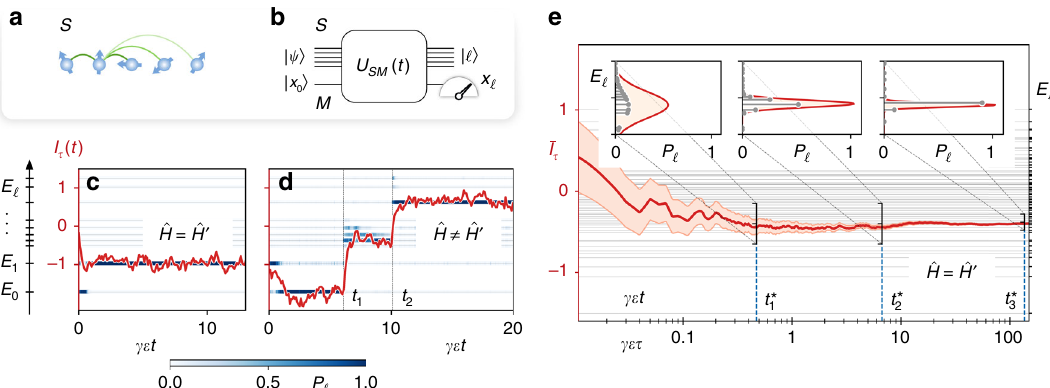
Fig. 1 QND measurement of a many-body Hamiltonian ^ H in a quantum simulator setting. The many-body spin system S , shown in a , is entangled with an R ^ H ^ H ^ P t t Þ ¼ exp f(cid:2) i ancillary system M (meter) by the unitary ^ U (cid:3) I þ ϑ ð t 0 Þ (cid:3) (cid:4)g . b Subsequent reading of a meter value x ‘ (cid:5) x 0 þ E ‘ d t 0 ½ SM ð 0 prepares the many-body system in an energy eigenstate ‘ j i with the eigenvalue E ℓ . c Single trajectory simulation (4) and (5) of an ideal QND measurement for the Ising Hamiltonian (3) for N = 5 spins, α = 1.5, h ∕ J = 1.5. The window- fi ltered homodyne current I τ ð t Þ (red curve) fl uctuates around a value corresponding to the eigenenergy prepared by the measurement of ^ H . The thin horizontal lines show the system eigenenergies E ℓ and the blue color indicates the conditional populations P ℓ ( t ) of the corresponding eigenstates. d Observation of quantum jumps due to the mismatch of the transverse fi elds ^ H 0 ¼ ^ H þ δ ~ h P ^ σ z δ ~ h = J ¼ (cid:2) 0 : 2. The fi ltered photocurrent (red) clearly shows sudden jumps between eigenstates at times t j with j energy eigenstates or microcanonical ensembles by the ideal QND measurement for N = 8 spins, α = 1.5, h/J = 0.8. The estimate of the system energy given by the cumulative time average of the homodyne current I τ (red line) gradually converges to a single eigenenergy (gray lines) as averaging time τ ffiffiffiffiffiffiffi γ ϵ τ p . Inset: conditional population of the energy eigenstates (gray increases. The corresponding uncertainty (red area) due to shot noise decreases as (cid:6) 1 = ffiffiffiffiffiffiffiffiffiffiffiffiffiffiffiffi p points) at times t (cid:8) , t (cid:8) , and t (cid:8) is well captured by gaussian distributions of widths J = 4 γ ϵ t (cid:8) describing the fl uctuations of the shot noise averaged over 1 2 3 1 ; 2 ; 3